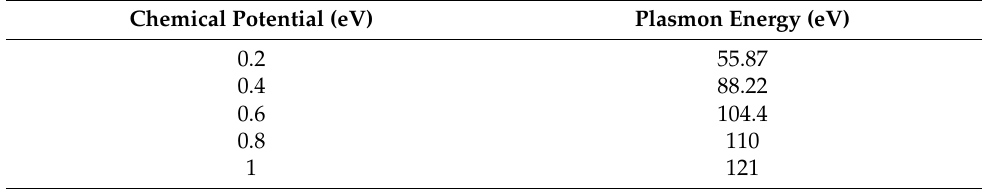
Table 1. Graphene plasmon energy in terms of chemical